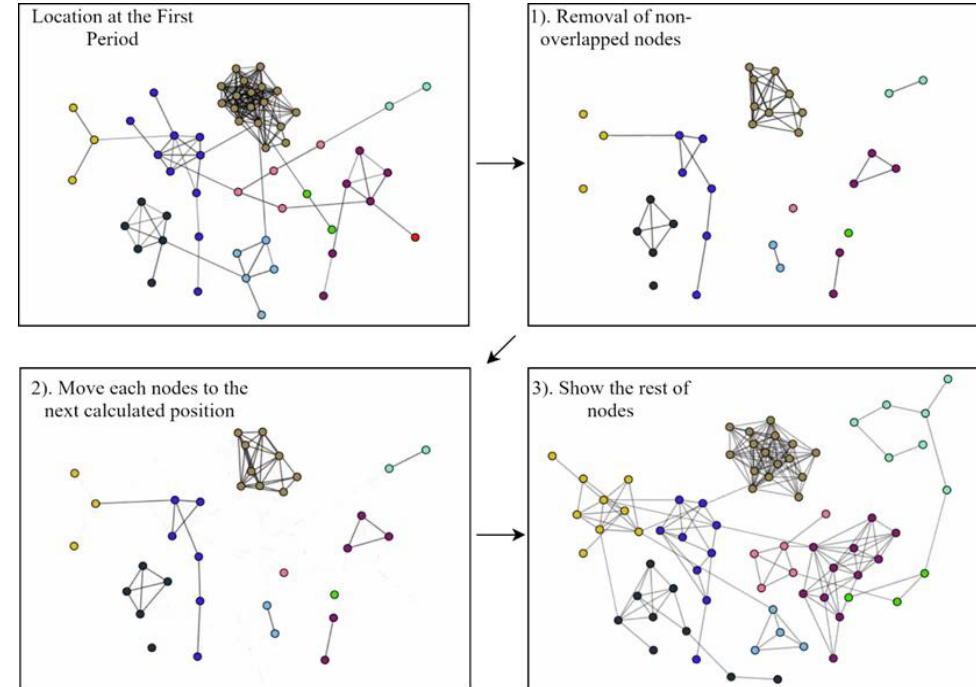
Figure 5. Transition animation procedure.